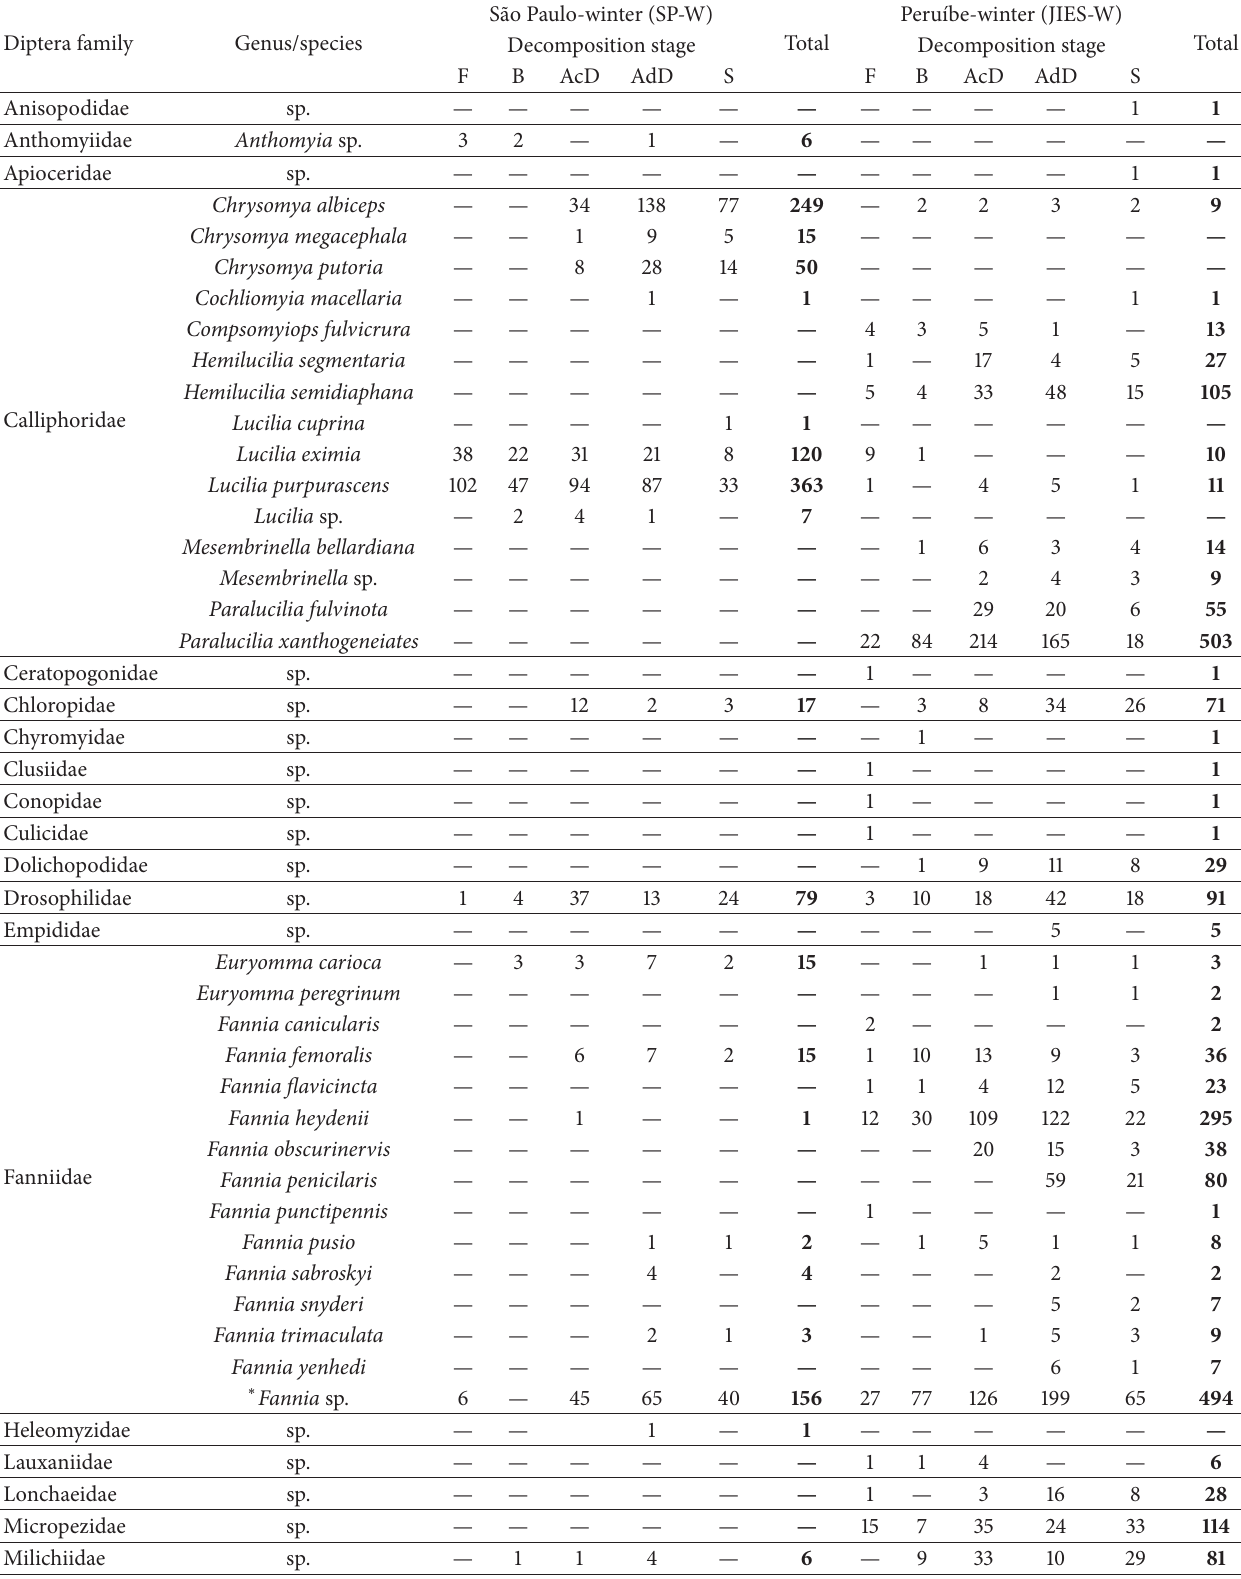
Table 3: Identification of Diptera collected during